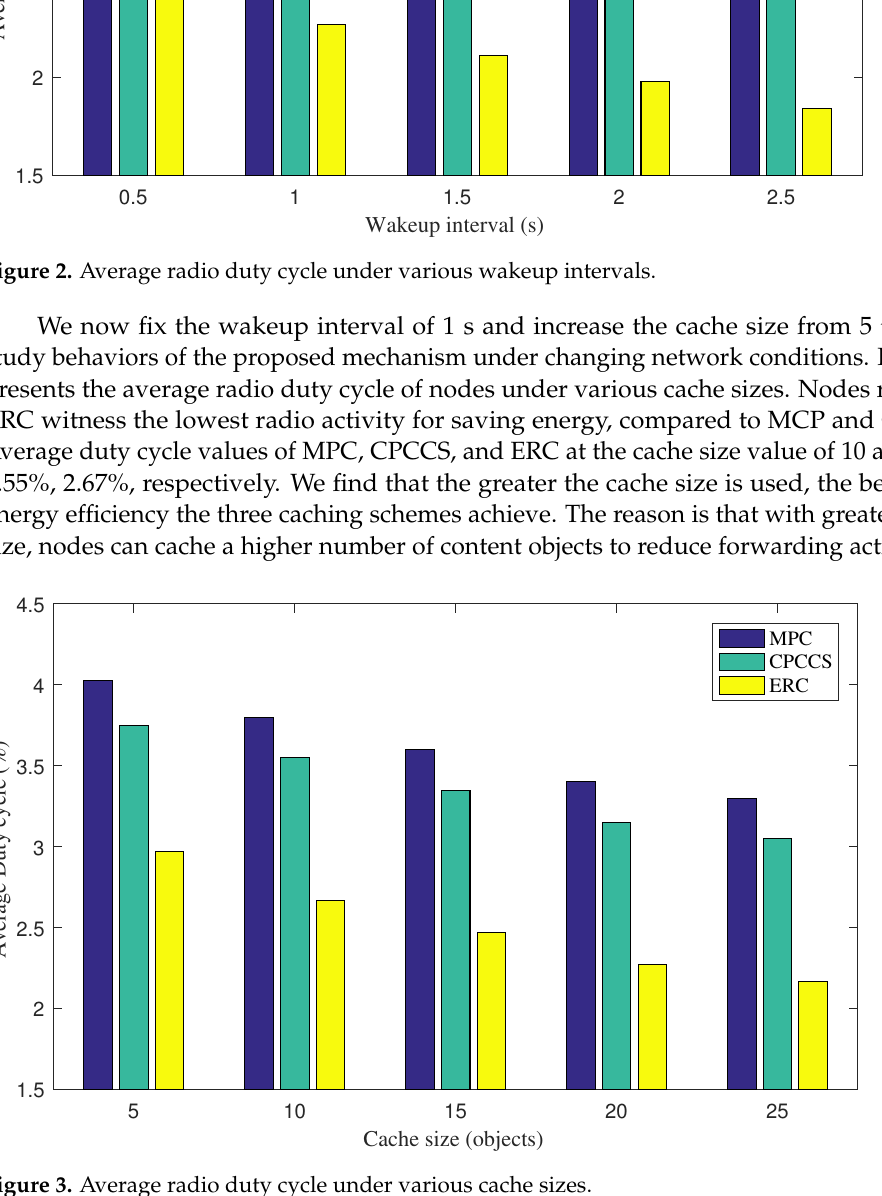
Figure 3. Average radio duty cycle under various cache